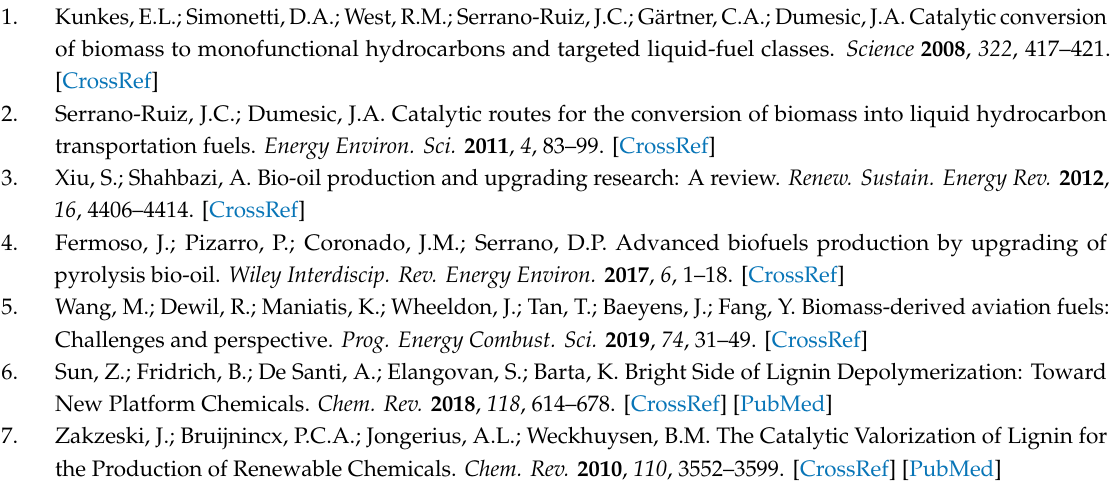
Figure S1: SEM images of HZ sample mixed with raw materials. ( a ) KL; ( b ) PL; ( c ) poplar. Table S1: Major identified compounds classification ( > 0.1%, relative peak area) by GC / MS. Table S2: Compounds used for GC / MS calibration. Table S3. Detailed product distribution by relative peak area of repeatability test of raw materials fast pyrolysis. Table S4. Detailed product distribution by relative peak area of repeatability test of KL CFP. Table S5. Detailed product distribution by relative peak area of repeatability test of PL CFP. Table S6. Detailed product distribution by relative peak area of repeatability test of poplar